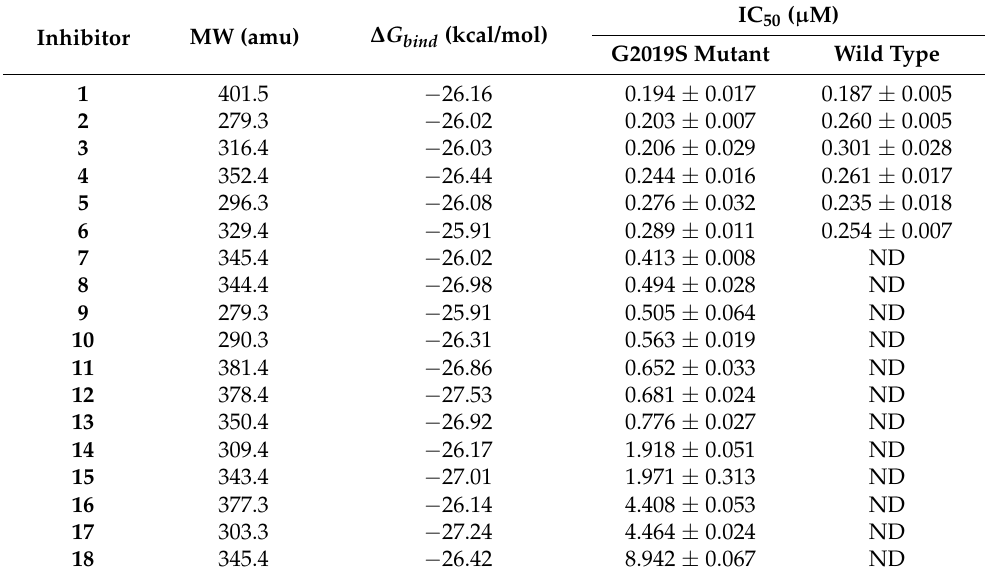
Table 1. Molecular weight (MW), calculated binding free energy ( ∆ G bind ), and IC 50 (in µ M) values of 18 new inhibitors of the G2019S mutant of